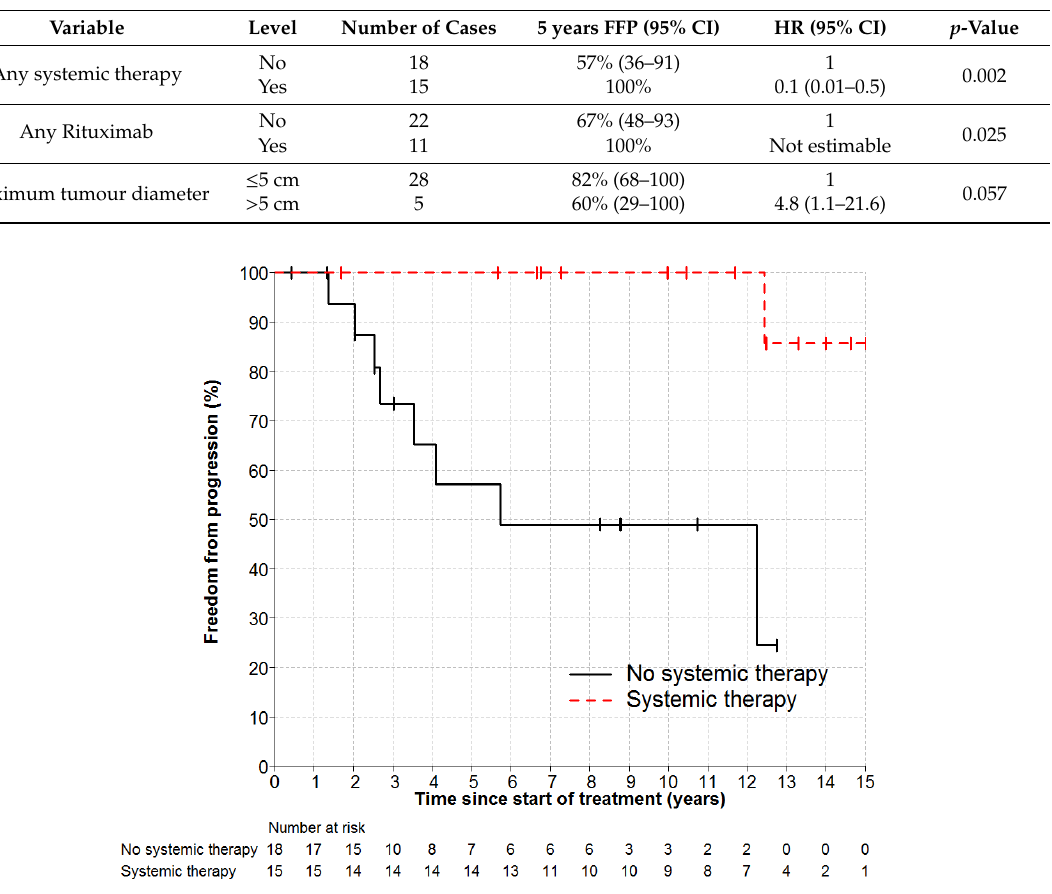
Table 4. Univariable analysis for Freedom-From Progression (FFP).